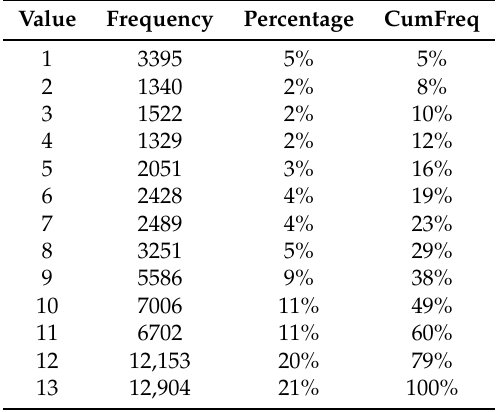
Table 2. Rating matrix for multi-criteria RSs.